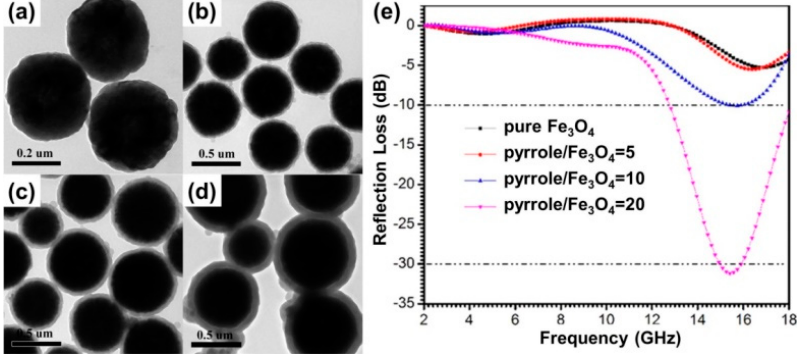
Figure 7. TEM images of ( a ) pure Fe 3 O 4 microspheres and Fe 3 O 4 @PPy core–shell composite microspheres prepared with different pyrrole/Fe 3 O 4 ratios: ( b ) 5; ( c ) 10; and ( d ) 20; and ( e ) their microwave reflection losses (absorber thickness = 2.5 mm) in the frequency range of 2–18 GHz. Reprinted with permission from Reference [89].